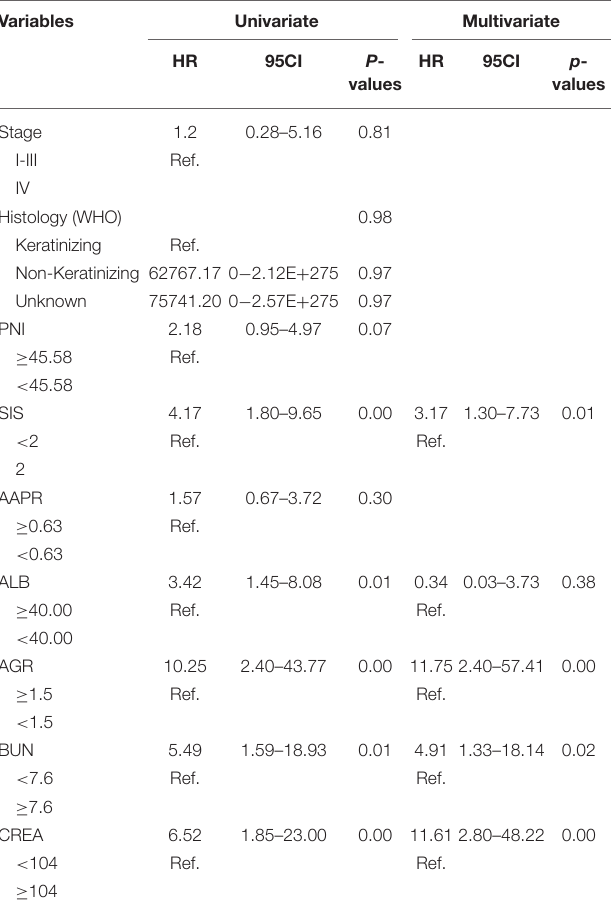
TABLE 4 | Univariate and multivariate Cox proportional hazards regression analysis for DFS. Variables Univariate